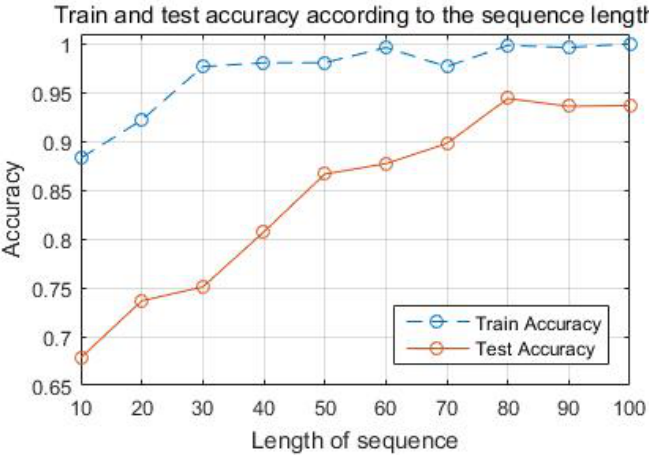
Figure 11. Classification accuracy with the sequence